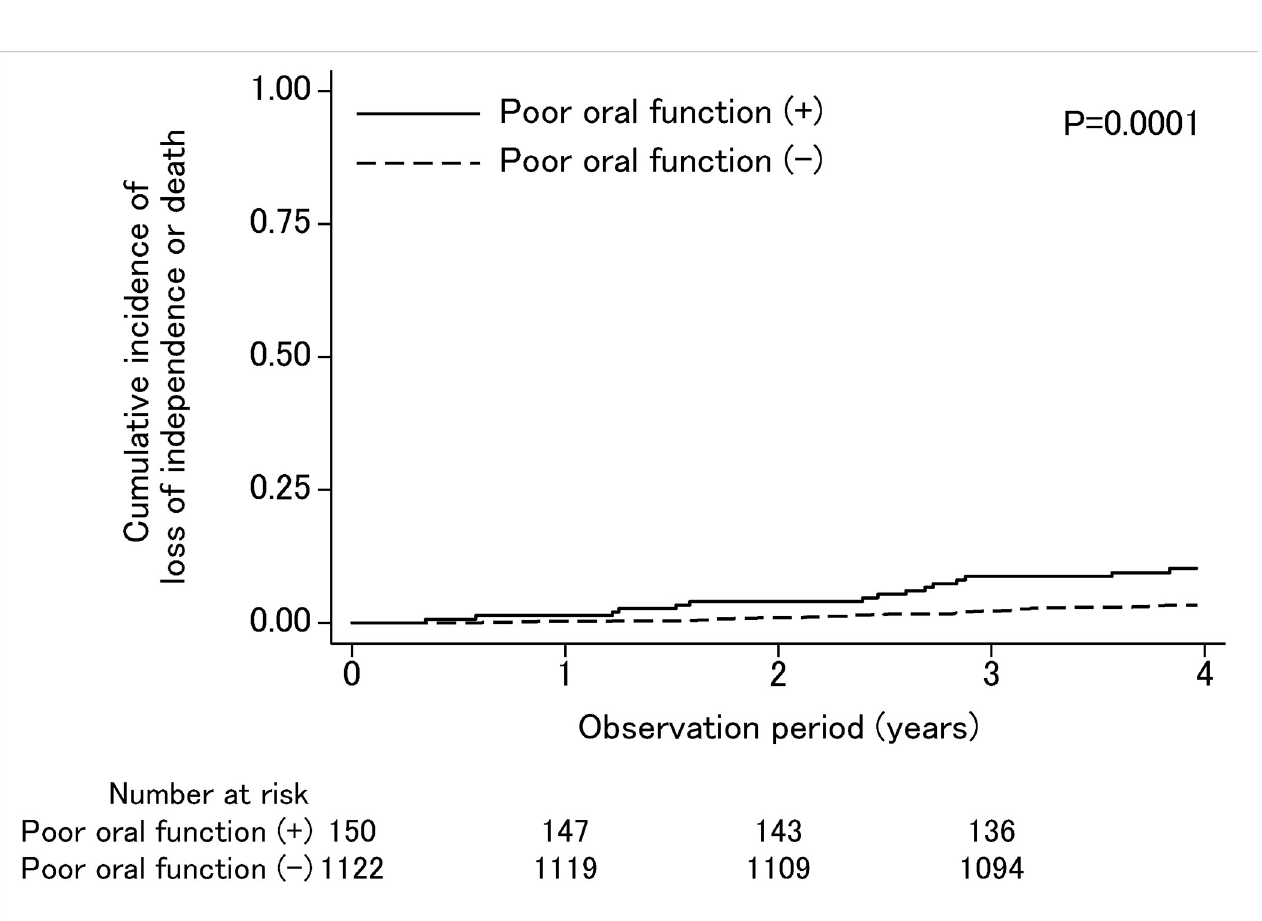
Fig 2. Kaplan–Meier curves of cumulative incidence of loss of independence or death according to the presence of poor oral function.